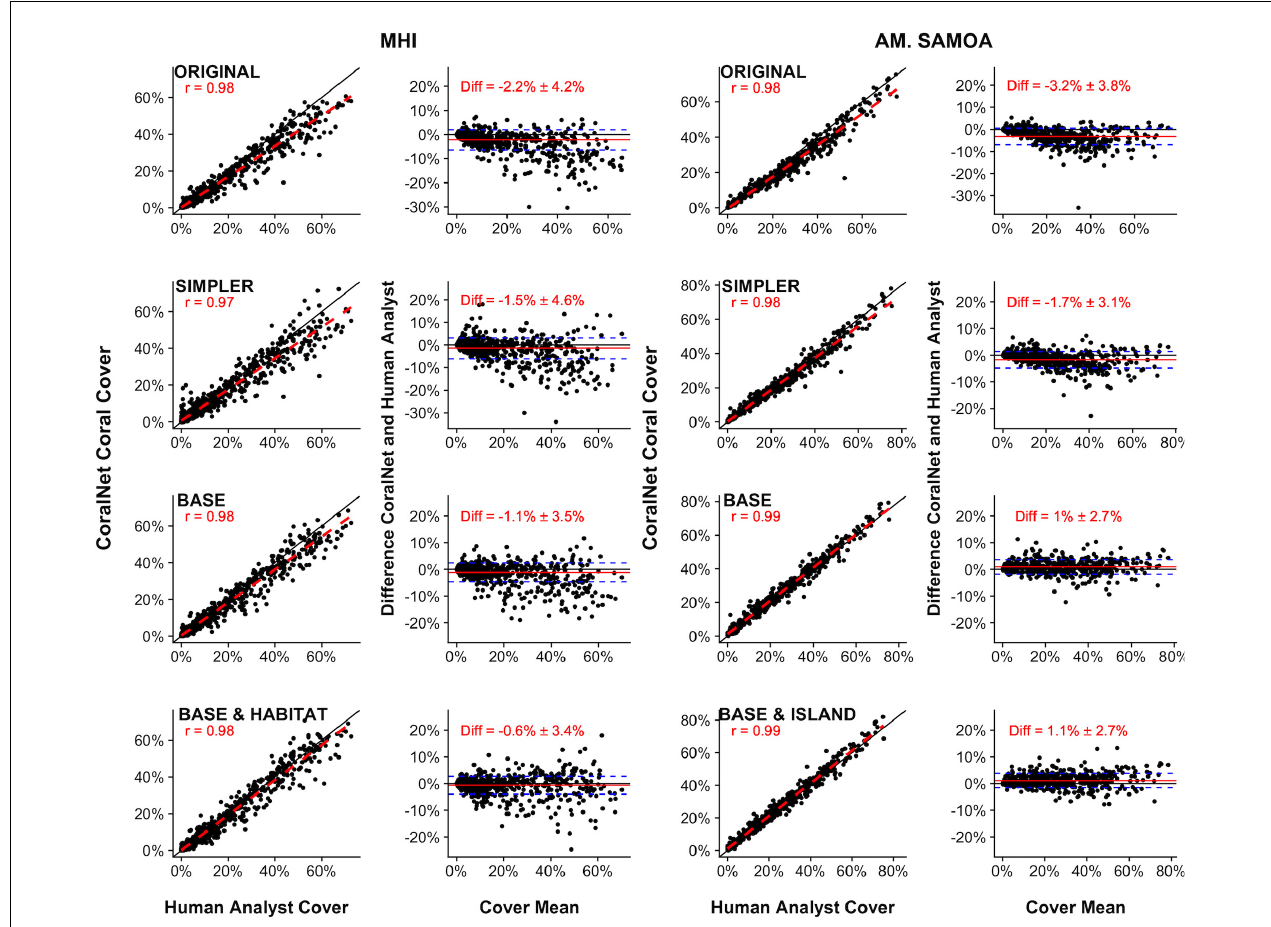
FIGURE 2 | Site-level coral cover by human analysts and CoralNet for different classification and training schemes. For each pair of figures, each point in the left-hand figures is a single site; the solid black line is the 1:1 line, the dashed red line is a linear fit of the point data, and “r” value shown is Pearson’s correlation. Each point in the right-hand figures is the difference between CoralNet and human-analyst cover estimates at a site, plotted against the mean of cover from the two annotation methods. The red horizontal line is the mean of the site-level difference in cover; and the blue dashed lines represent mean ± 1 standard deviation (SD). Training schemes are defined in Supplementary Table S2 , but go from most complex (“ORIGINAL,” in which corals and macroalgae are generally identified to genus and below) to most simplified (“BASE,” in which benthos is analyzed to functional group only). The bottom row represents schemes in which CoralNet was trained using the BASE classification but with sites filtered by habitat type for MHI (“BASE-HABITAT”) and by island for American Samoa (“BASE-ISLAND”) ( Supplementary Table S2 ). Total number of sites is 598 for MHI, and 468 for American Samoa. Correlations are significant ( p < 0.0001) in all cases.